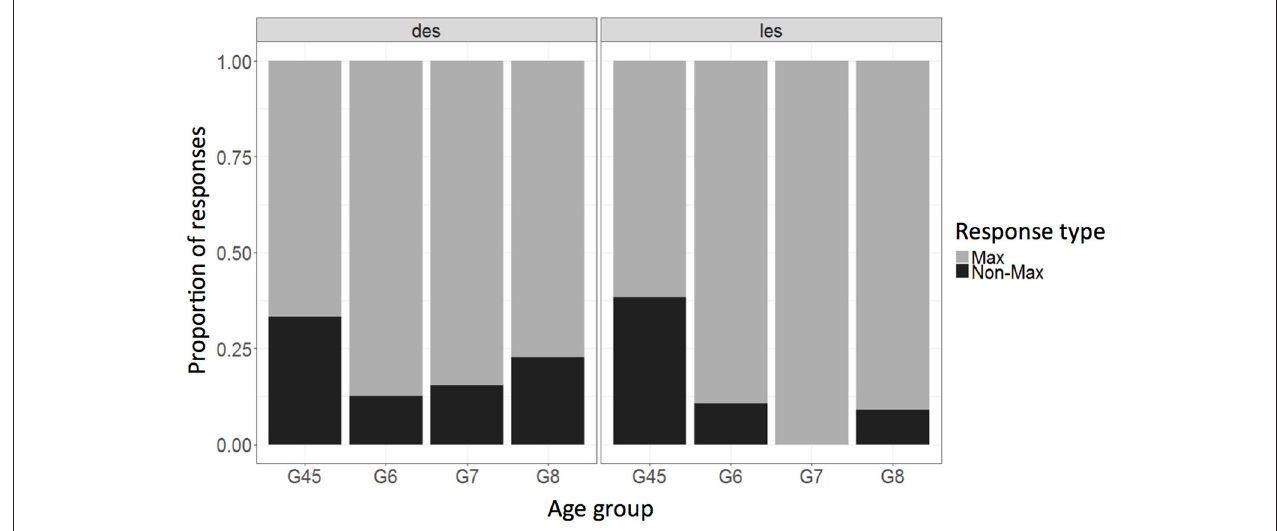
FIGURE 3 | Proportion of response types (maximal vs. non-maximal) in children by AGE (4–5, 6, 7, and 8 yo) and DEFINITENESS ( des , indefinite plural, vs. les , definite plura l ). See Figure 2 for adult results.